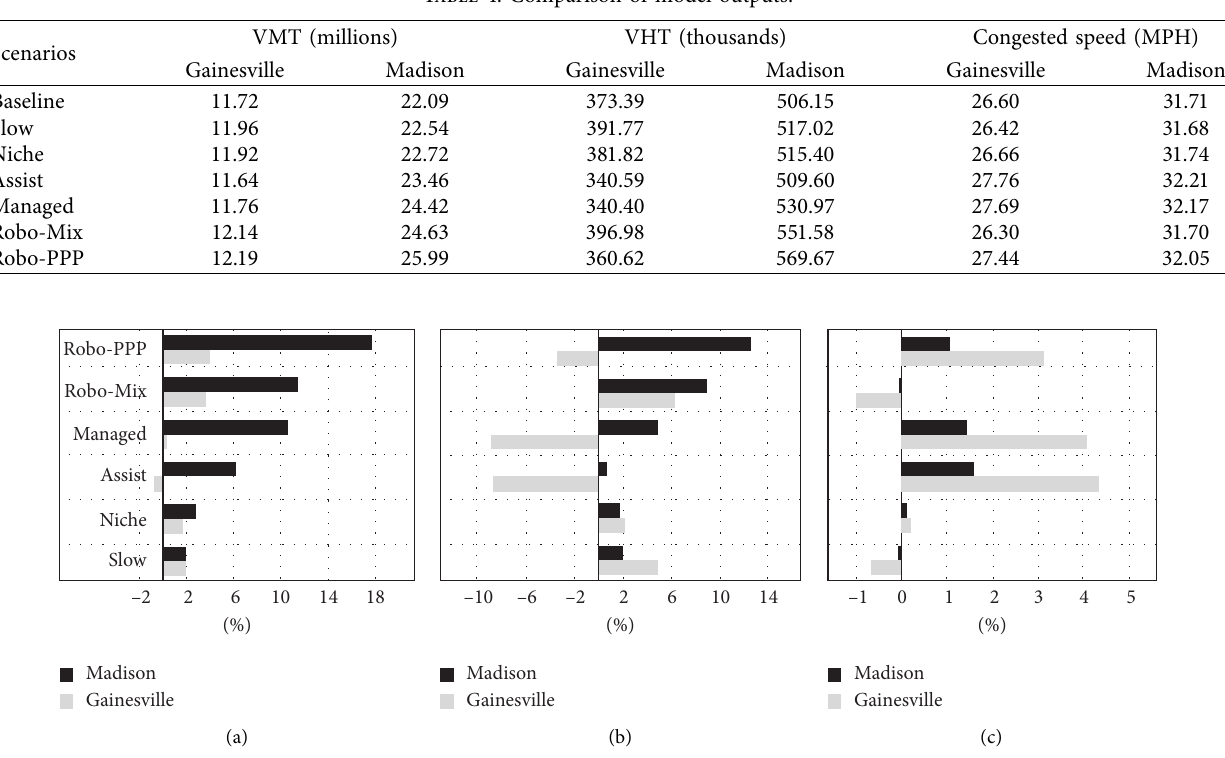
Table 4: Comparison of model outputs.